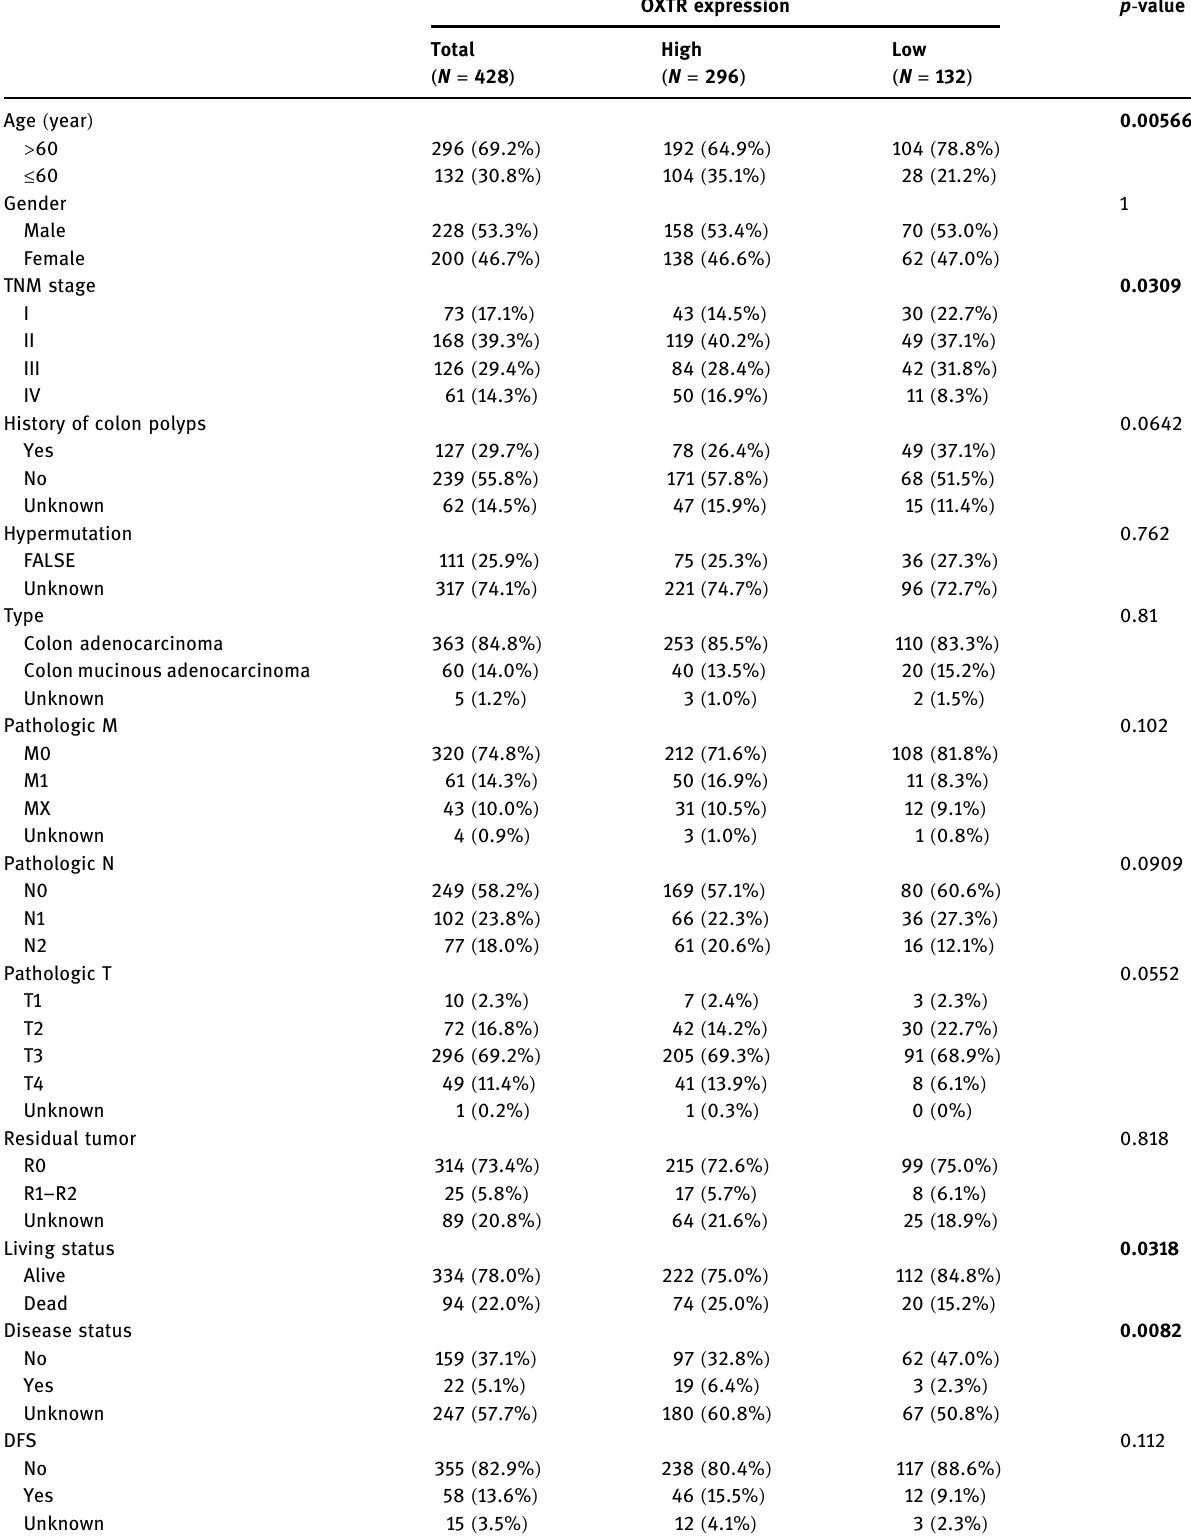
Table 1: Association between OXTR expression and the clinical parameters in patients with COAD in TCGA OXTR expression p -